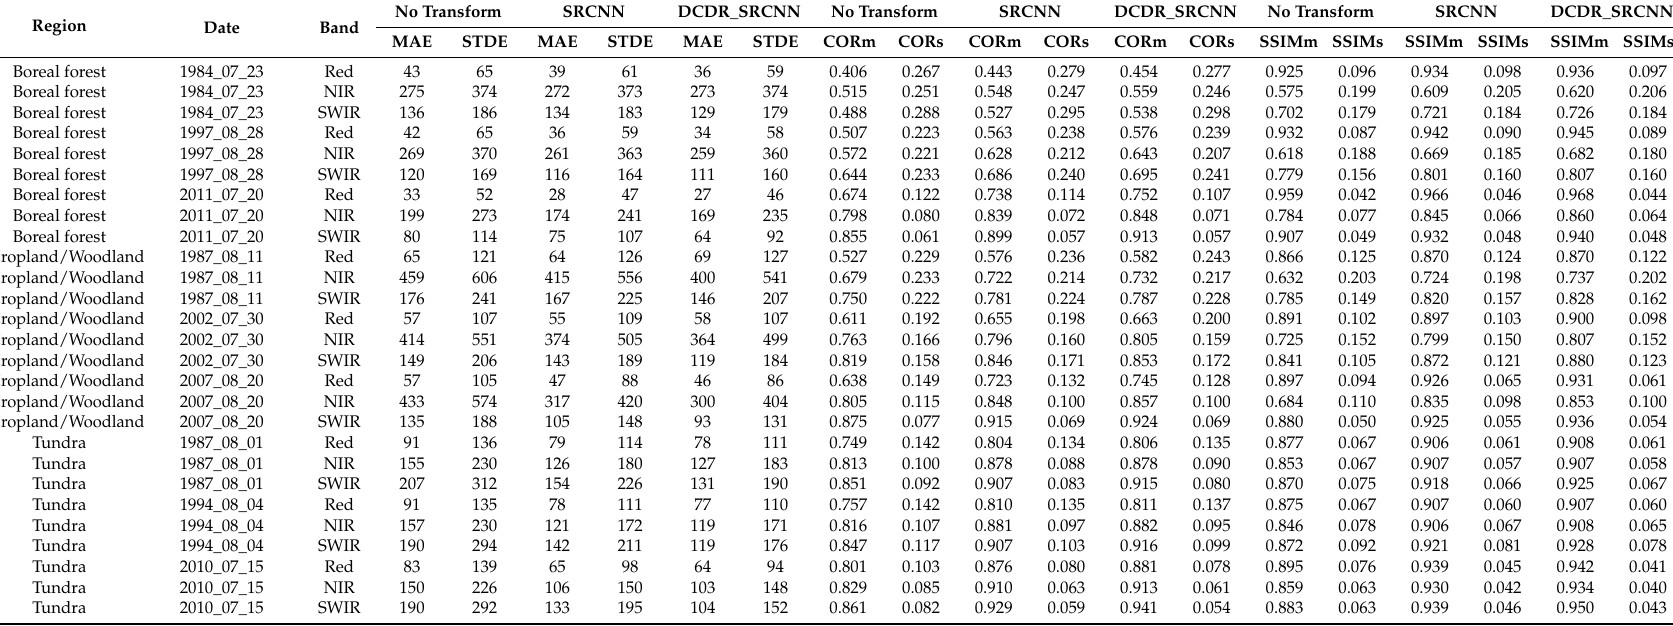
Table 4. Temporal extension performance